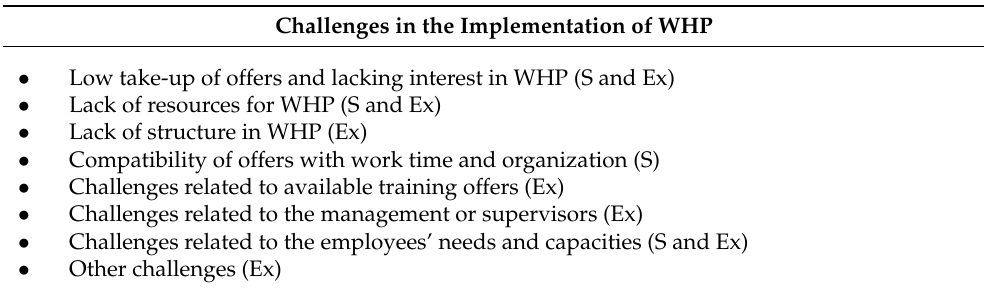
Table 6. Challenges in the implementation of WHP according to supervisors (S) and experts